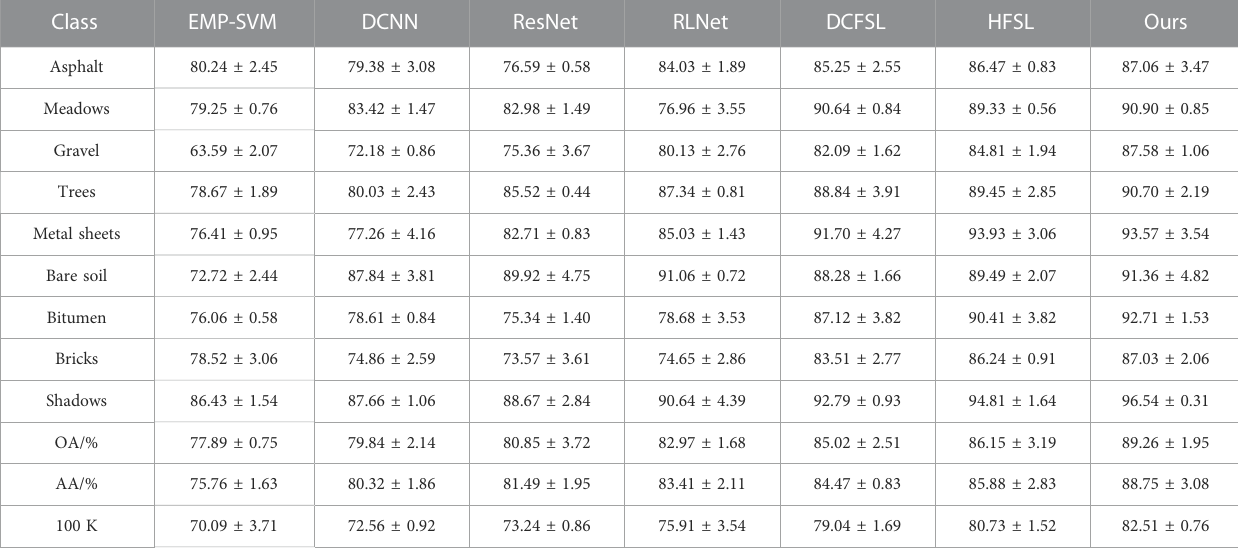
TABLE 1 Classi fi cation results of different methods on the Pavia University dataset.